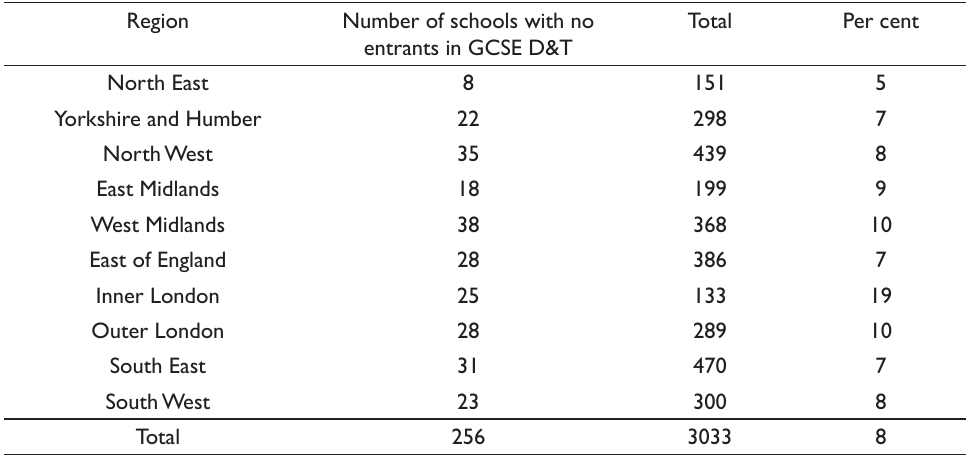
Table 2: Number of schools with no entrants in GCSE design and technology in 2014 by region Region Number of schools with no Total Per cent entrants in GCSE D&T North East 8 151 5 Yorkshire and Humber 22 298 7 North West 35 439 8 East Midlands 18 199 9 West Midlands 38 368 10 East of England 28 386 7 Inner London 25 133 19 Outer London 28 289 10 South East 31 470 7 South West 23 300 8 Total 256 3033